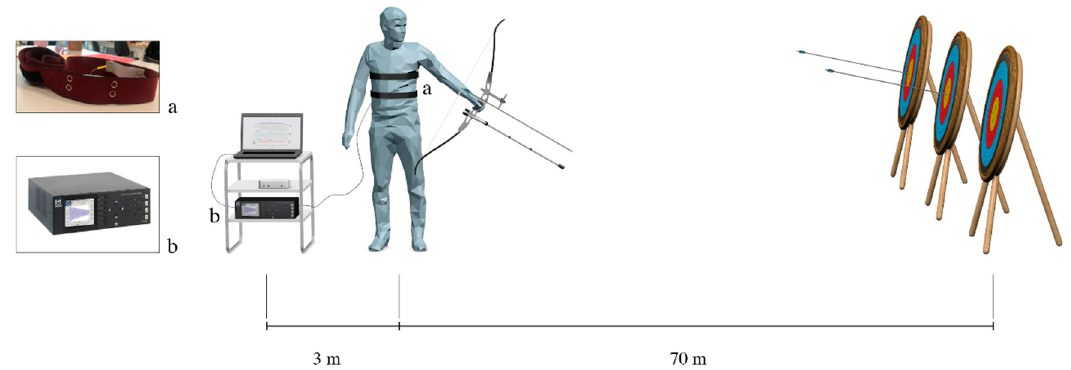
Figure 9. Experimental scenario during shooting session: ( a ) one of the band worn by the archer